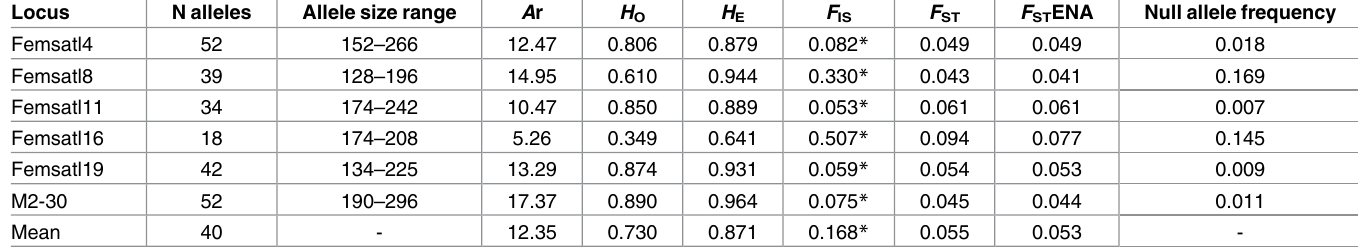
Table 2. Basic characteristics of the six nuclear microsatellite loci in Fraxinus excelsior used in this study. A r, allelicrichness, calculatedbasedon 13 diploidindividuals; H O , observed heterozygosity; H E , expectedheterozygosity; F IS , inbreedingcoefficient (the coefficients denotedwith asterisk ( * ) are sig- nificantlygreater than zero); F ST, coefficientof genetic differentiation among populations [63]; and F ST ENA, coefficientof genetic differentiation calculated using ENA correction